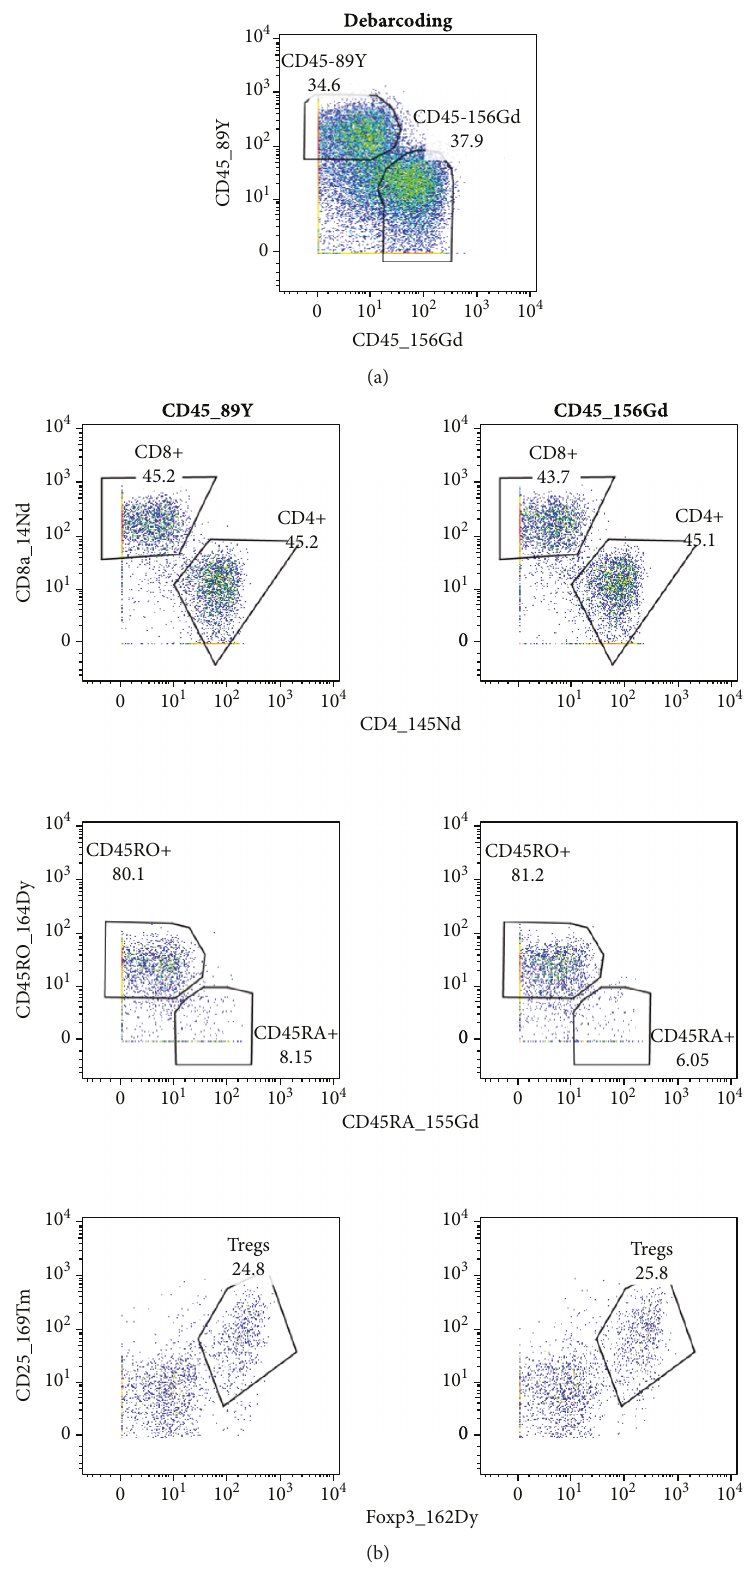
Figure 3: CD45-based barcoding. A single-cell suspension was prepared from tonsillar carcinoma, stained for live and dead cells, and halved for barcoding. After barcoding with CD45-89Y and CD45-156Gd antibodies, the samples were combined and stained with the rest of the antibodies. (a) Debarcoding and (b) dot plots with a selection of representative antigens. The same gates were applied to measured